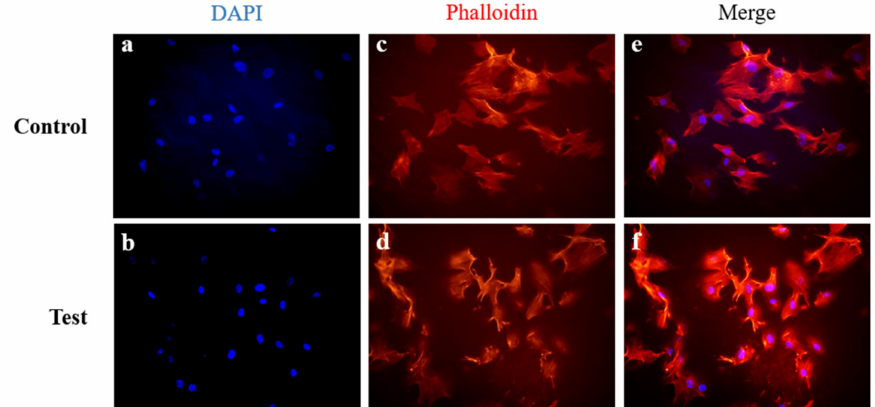
Figure 6. Immunofluorescent staining of human gingival fibroblasts (hGnFs) on membranes 2 h after seeding. ( a , b ) DAPI staining of cell nuclei; ( c , d ) rhodamine phalloidin staining of F-actin; ( e , f ) merged image; ( a , c , e ) non-cross-linked collagen membrane; ( b , d , f ) EDC-cross-linked collagen membrane. Control is represented by non-cross-linked collagen membrane; Test is represented by EDC-cross-linked collagen